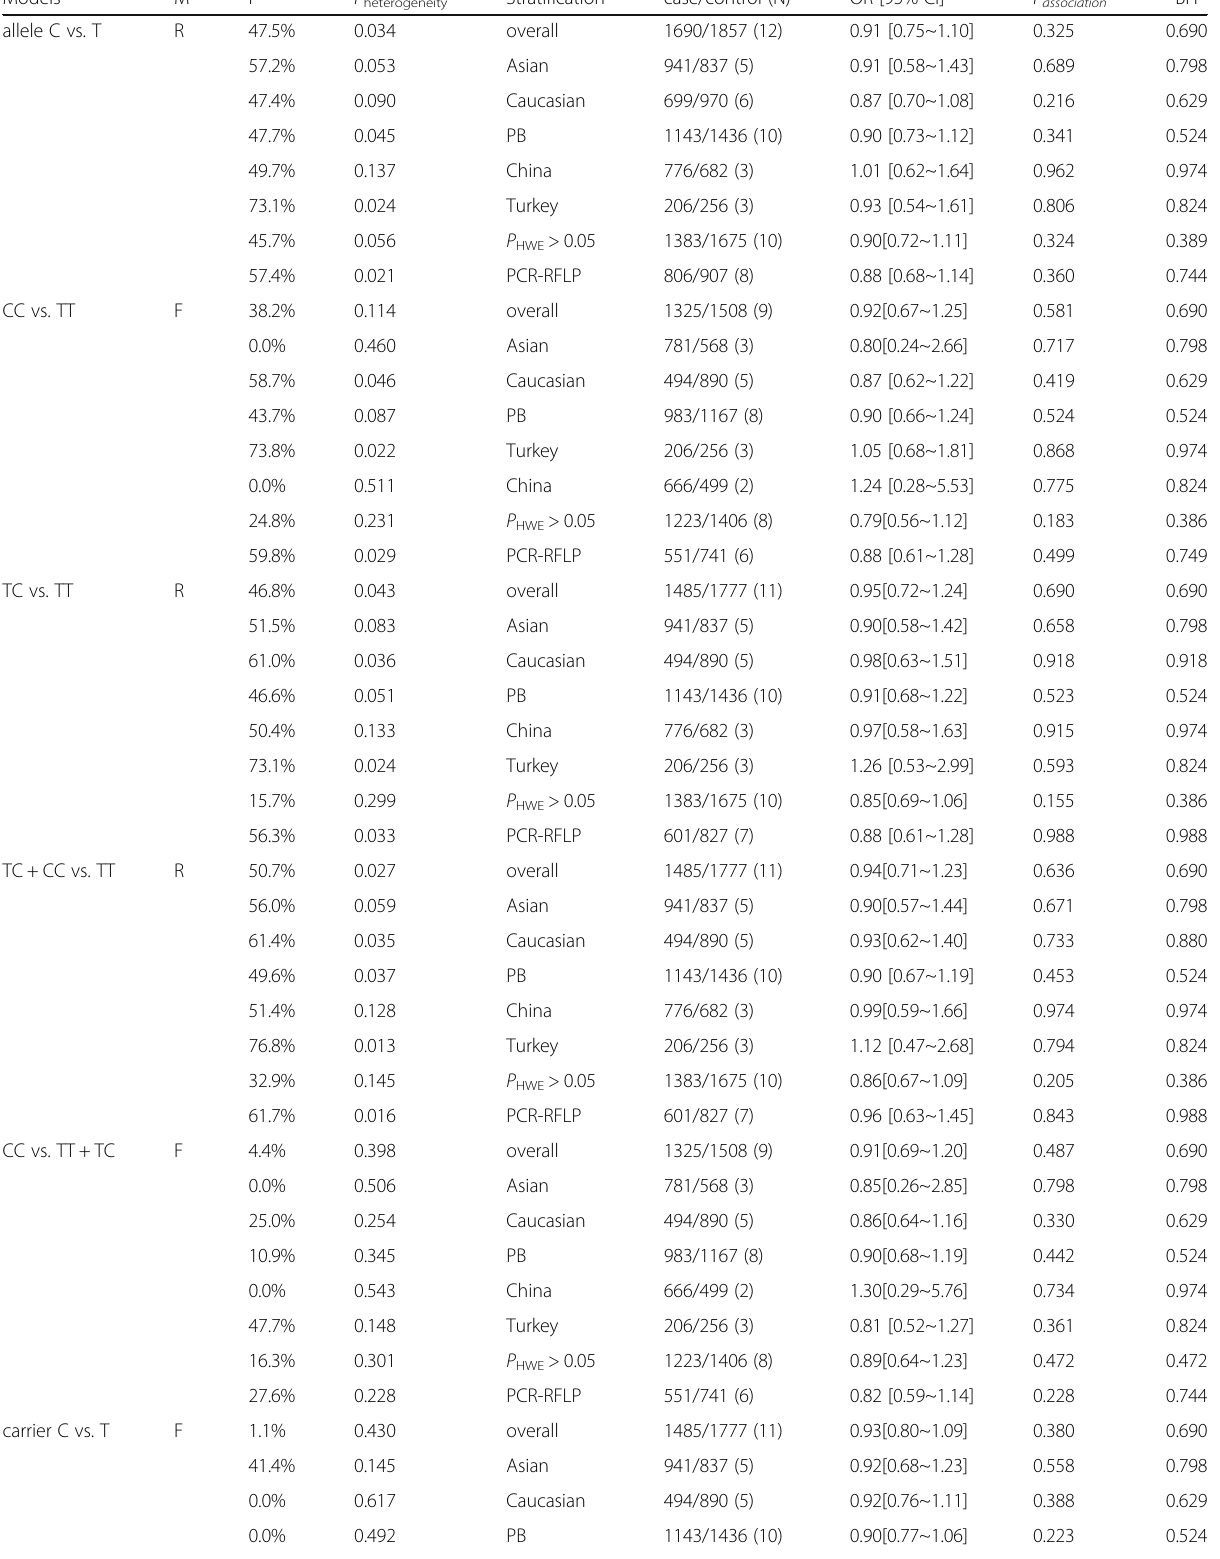
Table 5 Pooled analyses of the association between VDR rs731236 polymorphism and susceptibility to psoriasis Models allele C vs. T